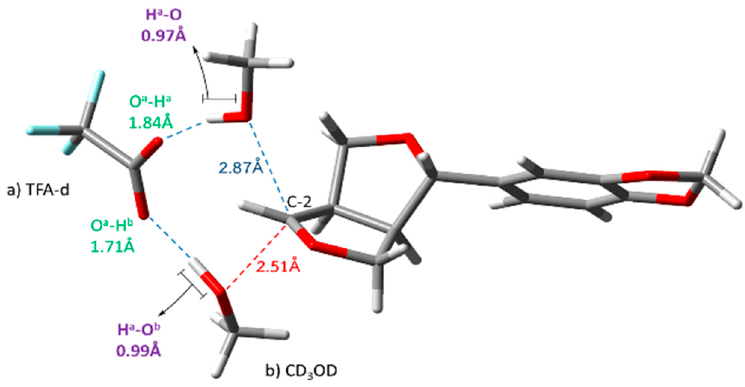
Figure 8. Transition state for the epimerization reaction of 2 β -10 .